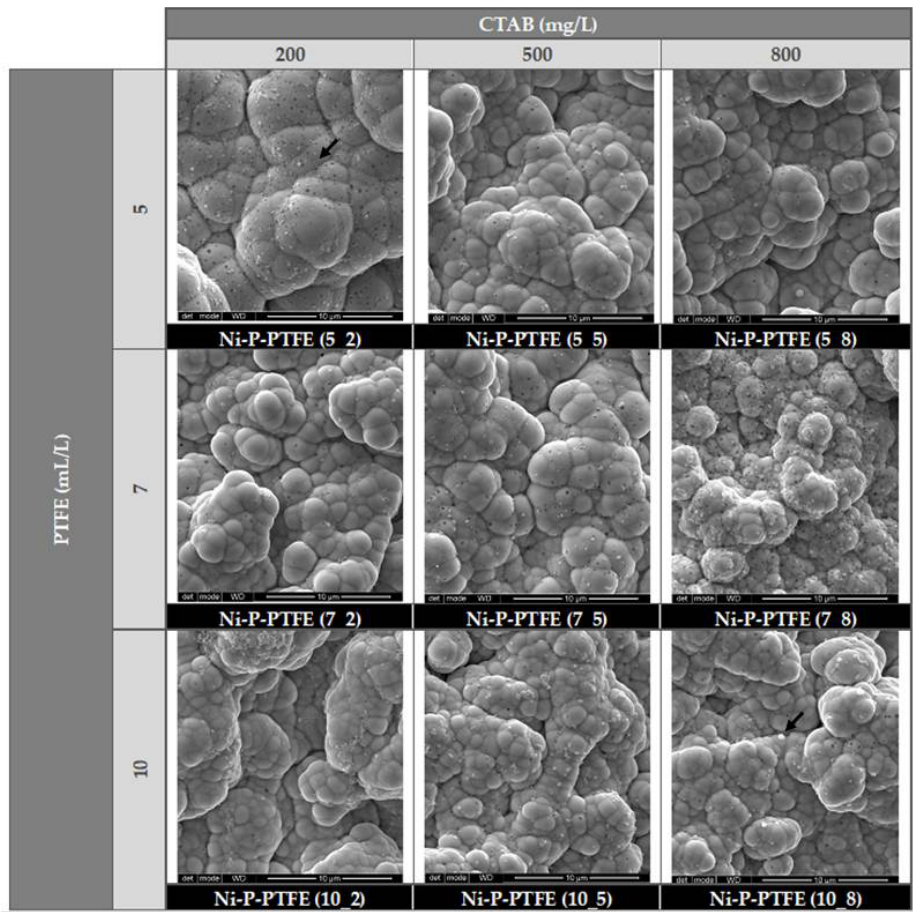
Figure 2. SEM micrographs of Ni-P-PTFE samples on NBR varying CTAB and PTFE concentra- tion. The designation of each sample is written bellow its corresponding micrograph. Arrows indicate PTFE particles.